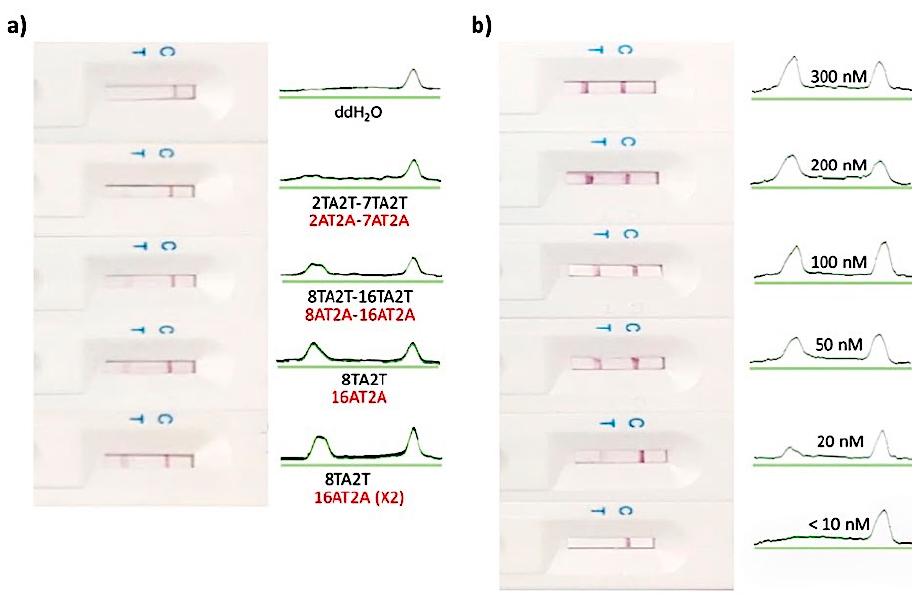
Figure 2. Optimization of reporter length and concentration. ( a ) Different length of 100 nM water-dissolved reporter sequences (in black) applied on the LFB test line complementary probe (in red). ( b ) Different concentrations of 8TA2T reporter applied on the LFB with 16AT2A (×2) complementary probe.